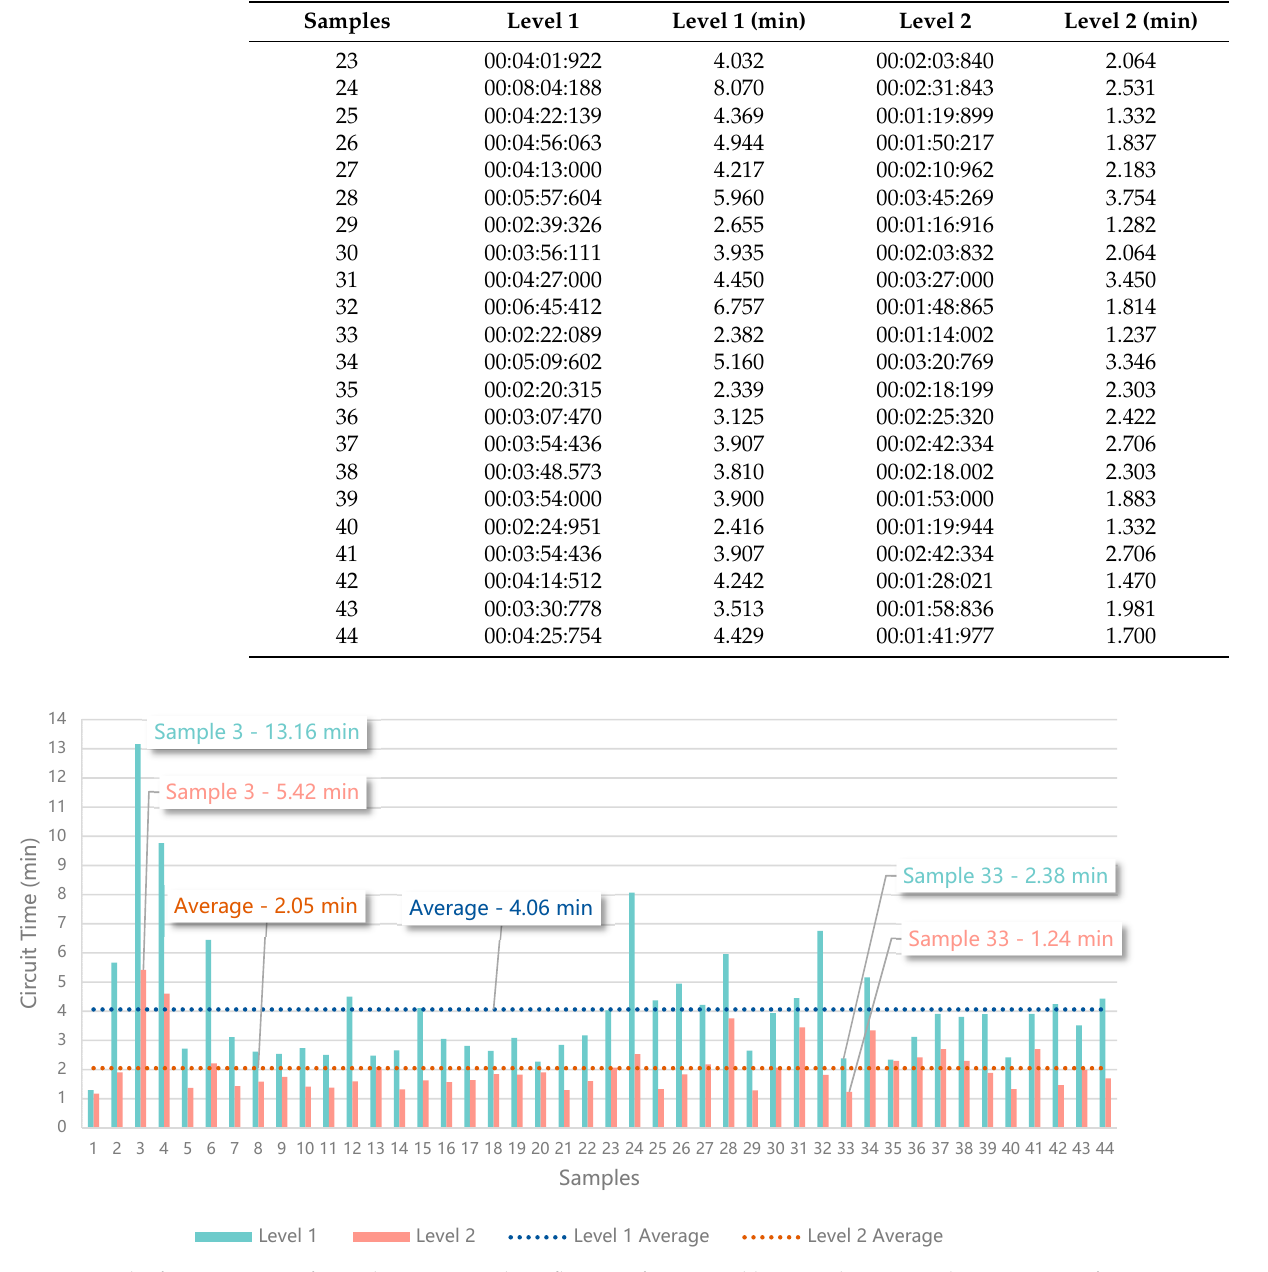
Figure 18. Results from Test 3, performed to measure the influence of AR visual hints in decreasing the circuit time for users that are controlling a UAV for the first time in an unknown trajectory.